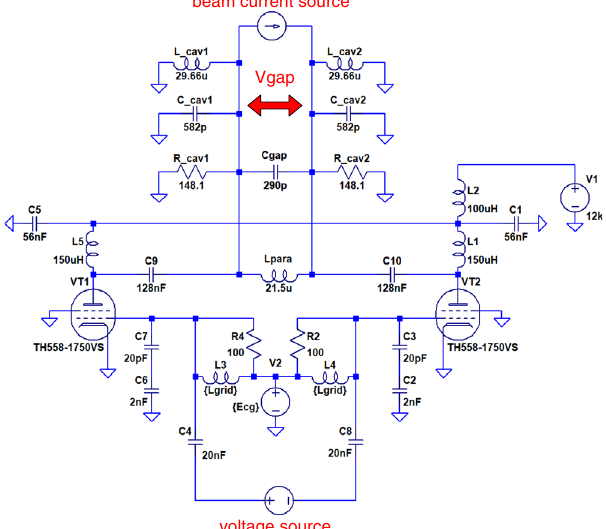
FIG. 2. Circuit model including the cavity, amplifier, and